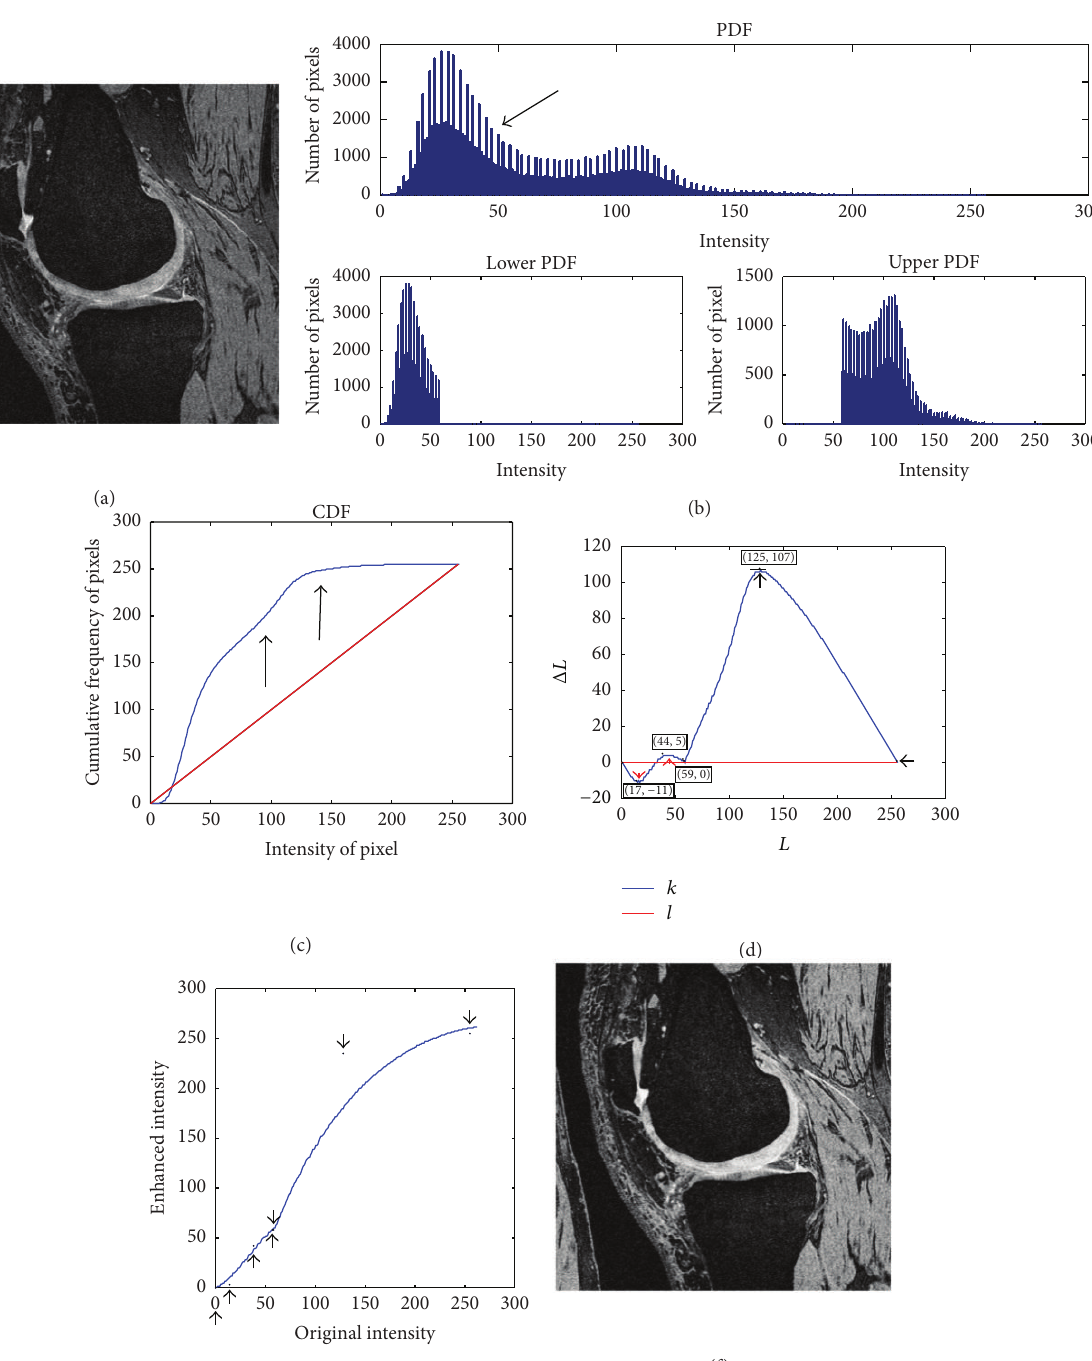
Figure 1: Flow of BBCCE computation using knee MR image. (a) Original MR image. (b) Upper diagram shows histogram of original MR image where black arrow indicates dominant background intensities and lower diagrams show the decomposition of histogram into lower and upper subhistograms in BBCCE. (c) Cumulative density function of original MR image where black arrows indicate large intensity distortion which contributes to sudden jump issue. (d) Intensity discrepency curve duduced from cumulative density function where upward and downward red arrows indicate global maximum and global minimum in lower histogram while upward black arrow indicates global maximum in upper histogram. Leftward black arrow defines the boundary for global extremum in intensity discrepency curve. (e) Bezier transform curve generated using control points duduced from intensity discrepency curve. (f) BBCCE enhanced MR